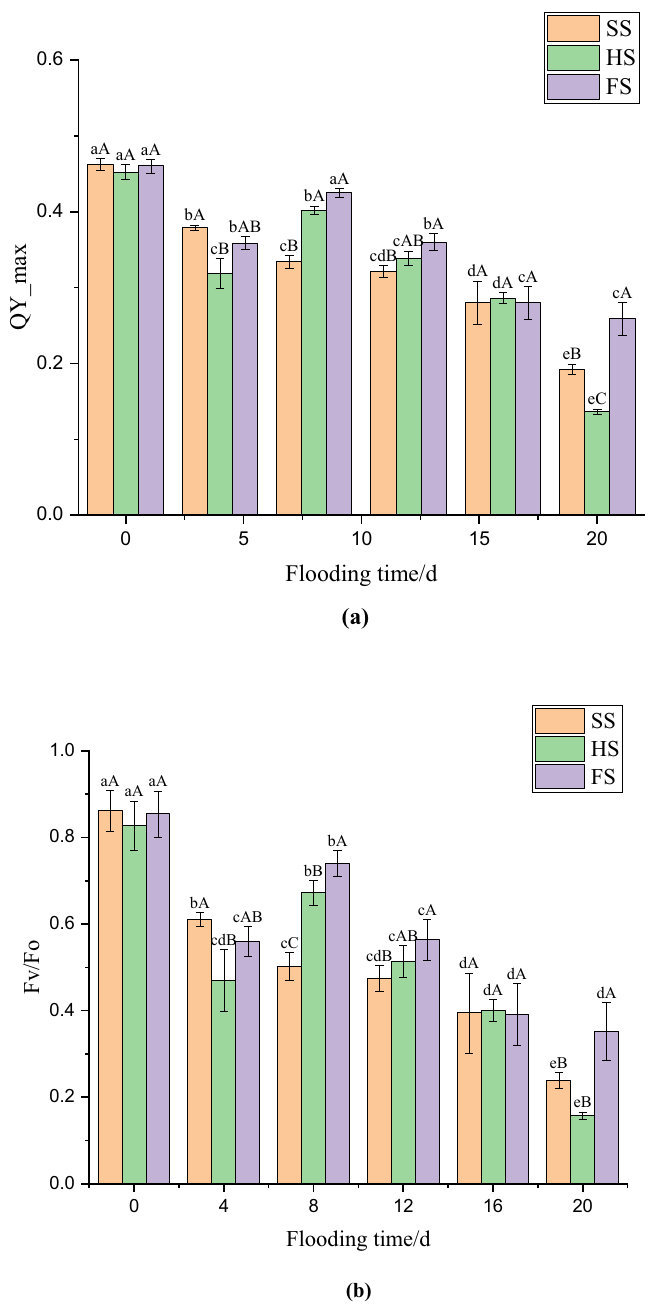
Figure 3. Effect of submergence stress on QY_max and Fv/Fo in Morus alba. Different uppercase letters indicate that the means of the different groups at the same time are significantly different ( p < 0.05), and different lowercase letters indicate that the means of the same group at different times are significantly different ( p < 0.05). This figure was drawn using Origin Pro 2021 v.